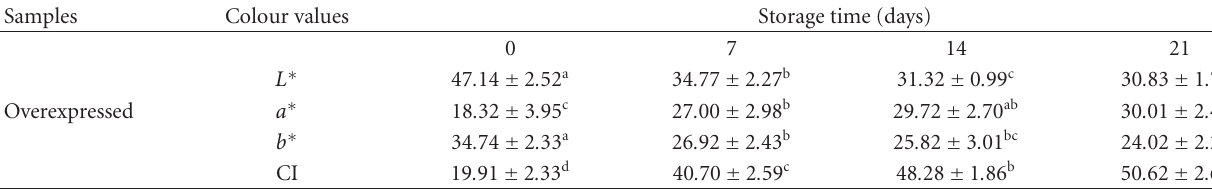
Table 4: Colour data for tomato overexpressed at 7, 14, and 21 days of storage.